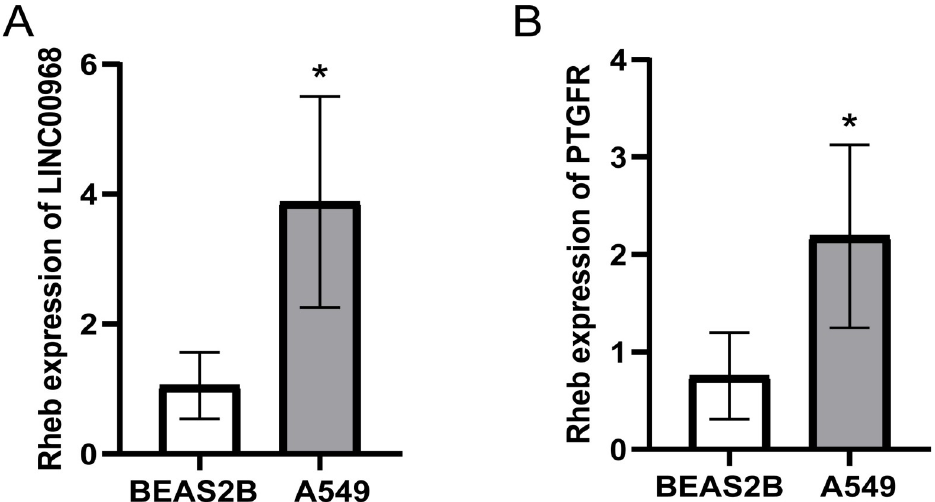
Fig 10. Verification of differentially expressed mRNA in BEAS2B and A549. LINC00968 (A) and PTGFR (B) were detected by qRT-PCR.